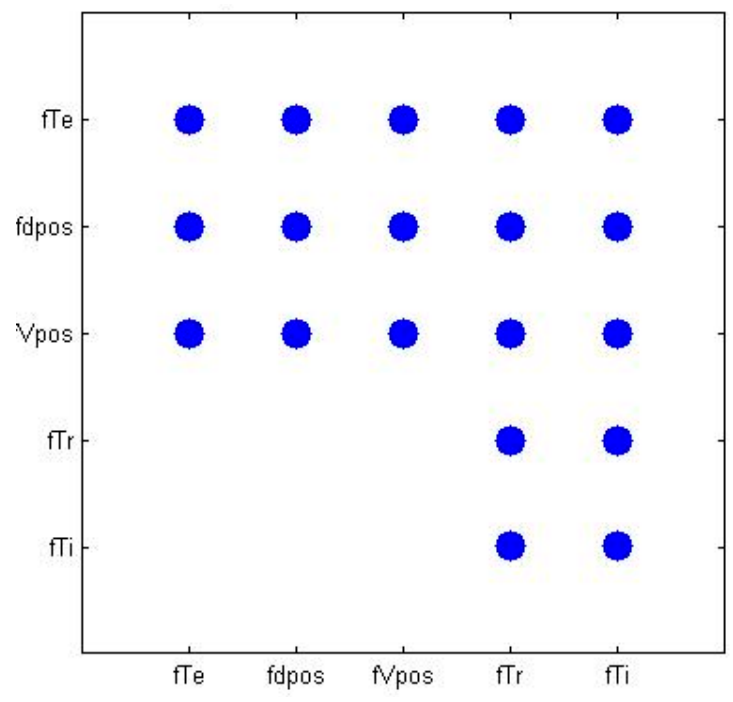
Figure 4. Fault isolability matrix for scenario 2.